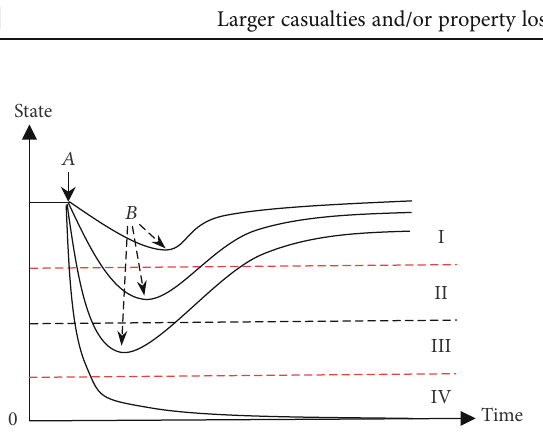
Figure 4: System state curves for the four vulnerability grades.